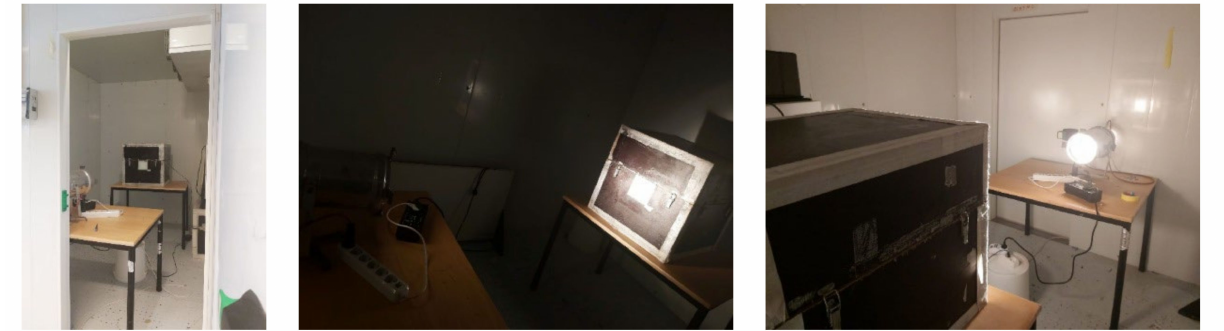
Figure 7. The experimental setup in the climate chamber (Riga Technical University laboratory).